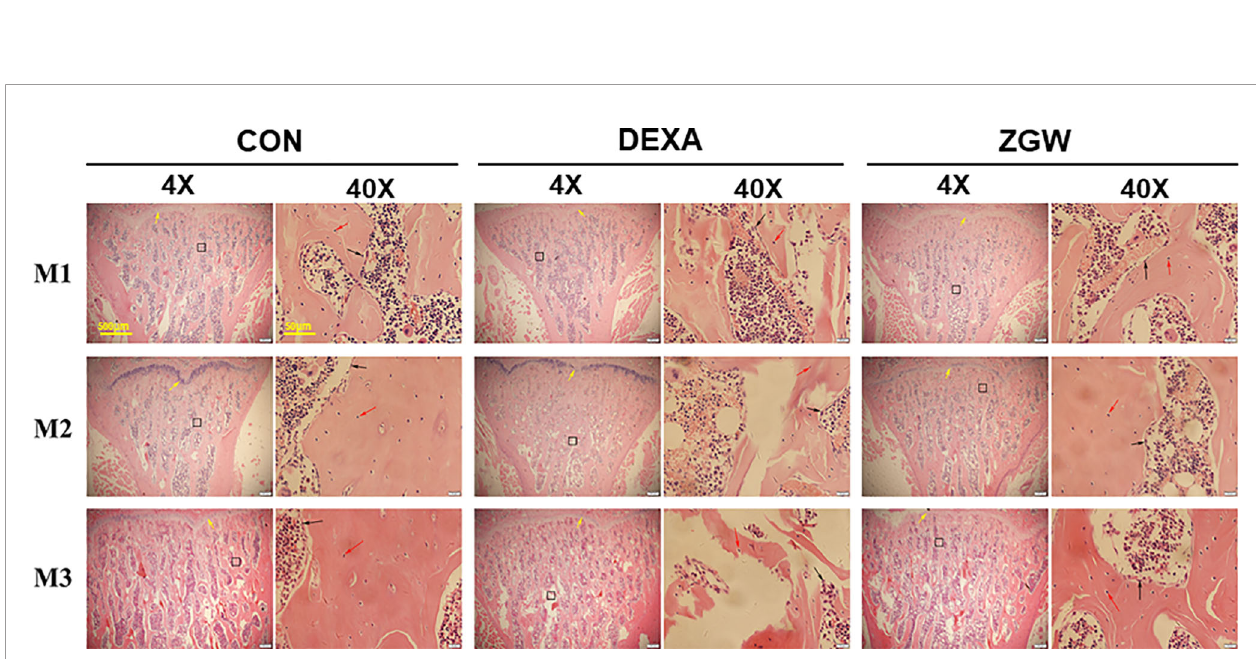
FIGURE 3 | Changes of bone histomorphology examined by H&E staining in the L4 bone trabecula of rats in each group. Scale bars and magni fi cations are displayed on the images. The red arrows represent osteocytes; the black arrows represent osteoblasts.